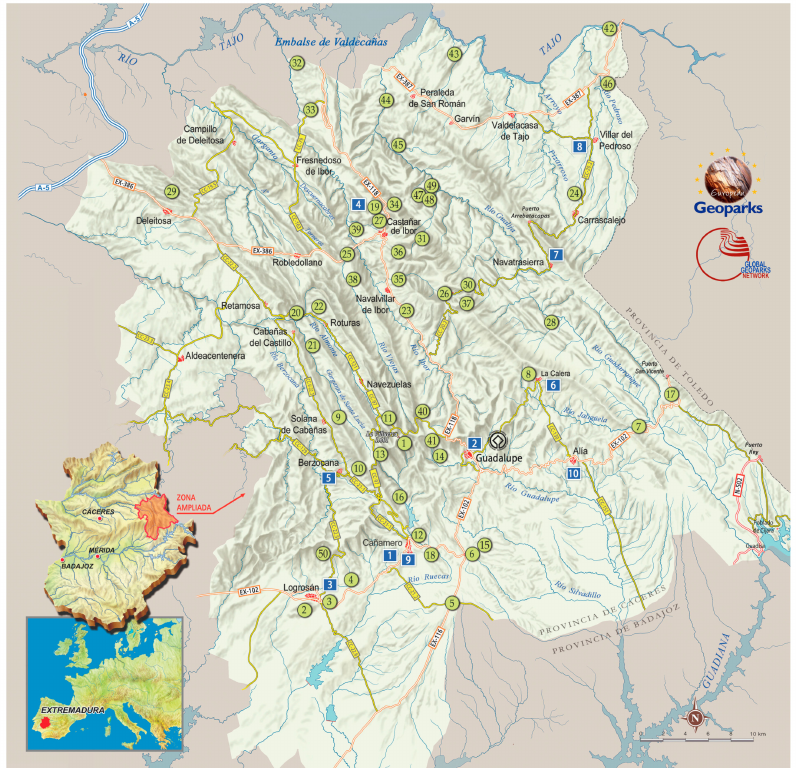
Figure 1. Location of the UNESCO Global Geopark Villuercas-Ibores-Jara and distribution of geosites. Source: UNESCO Global Geopark Villuercas-Ibores-Jara